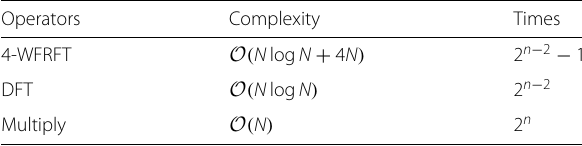
be employed in the weight coefficients multiply.